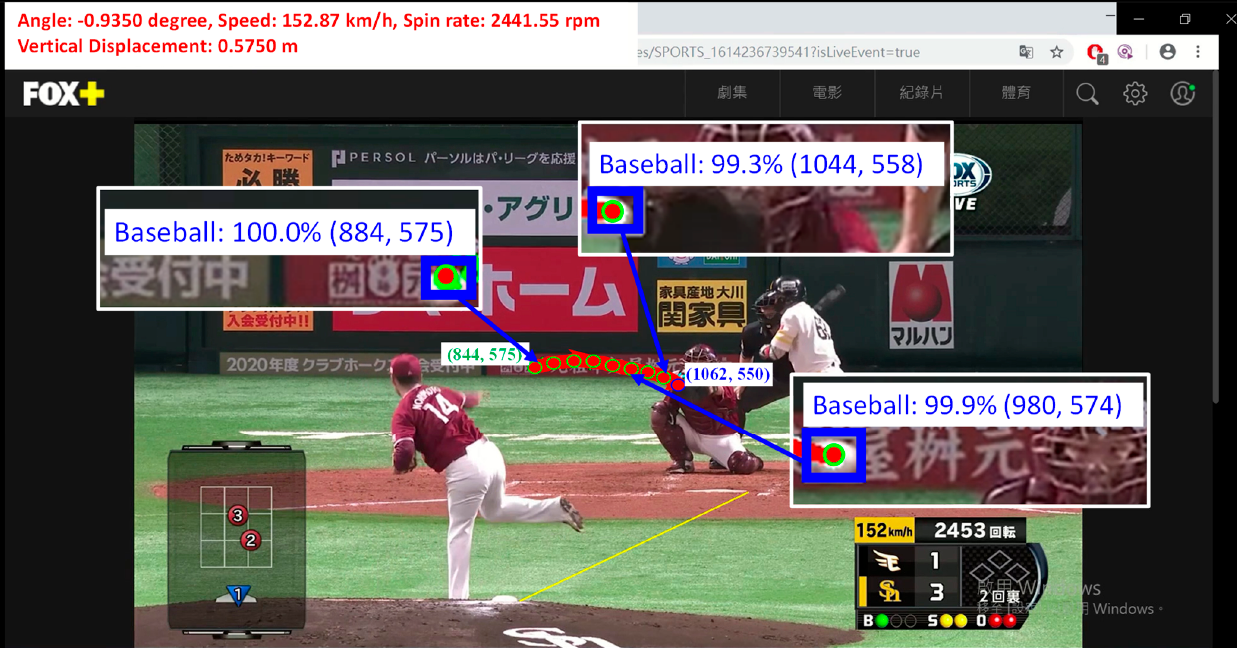
Figure 9. Automatic measurement result for a forkball.